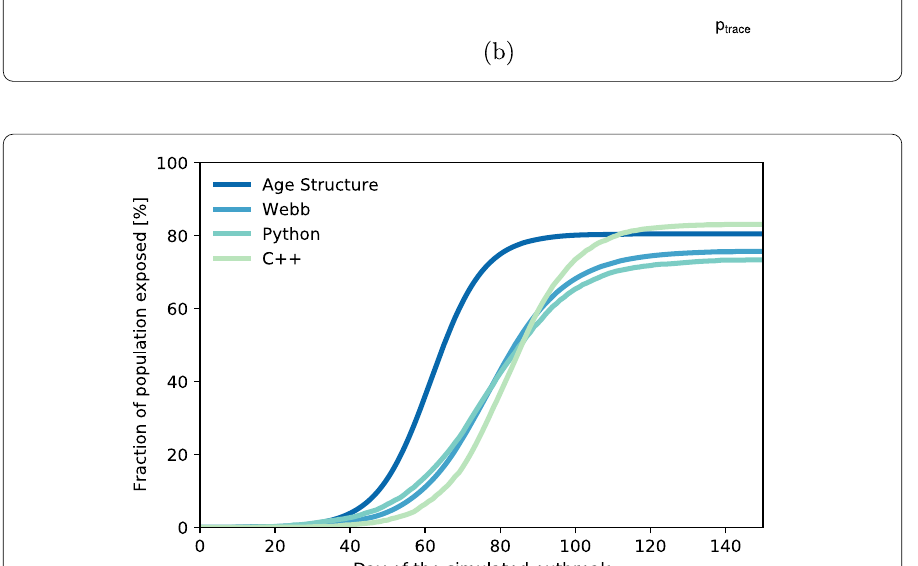
(cid:7) (cid:8) (cid:8) app2 η . (0)) ≈ R eff DCT p eff